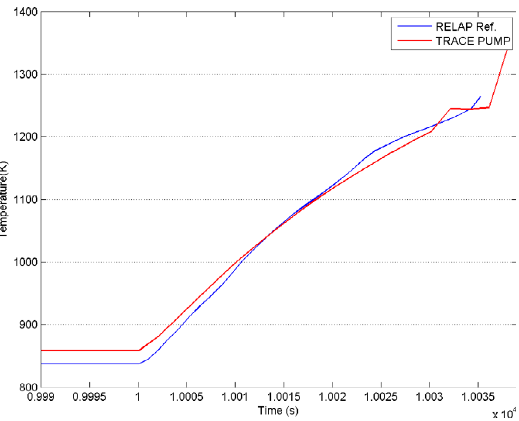
Fig. 16. Coolant mass fl ow reduction (%) in one loop (3D). Moment of inertia sensitivity analysis.